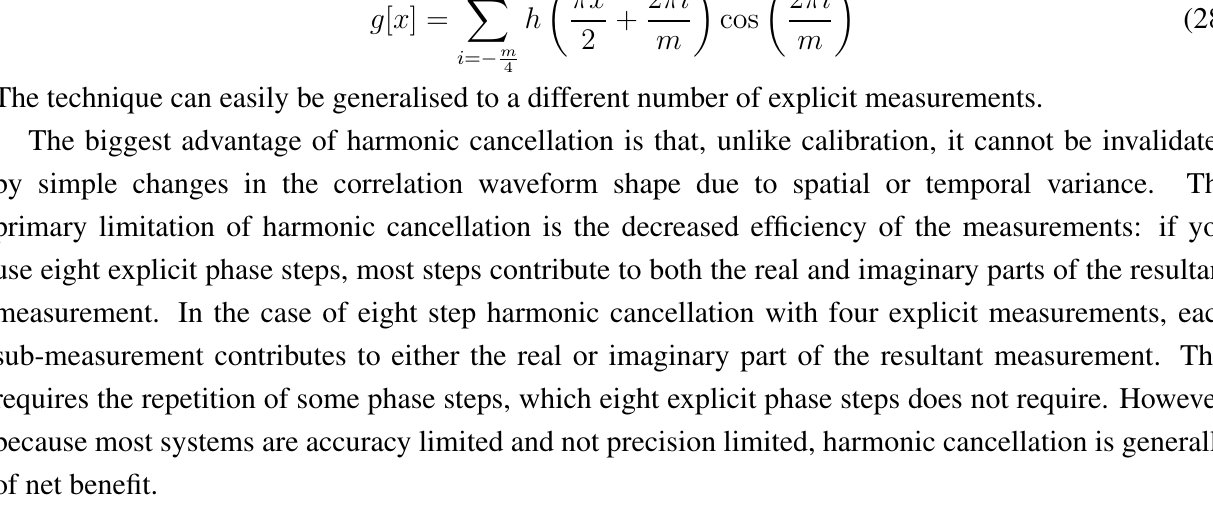
Figure 8. Evaluating Advanced Aliasing Mitigation Methods.